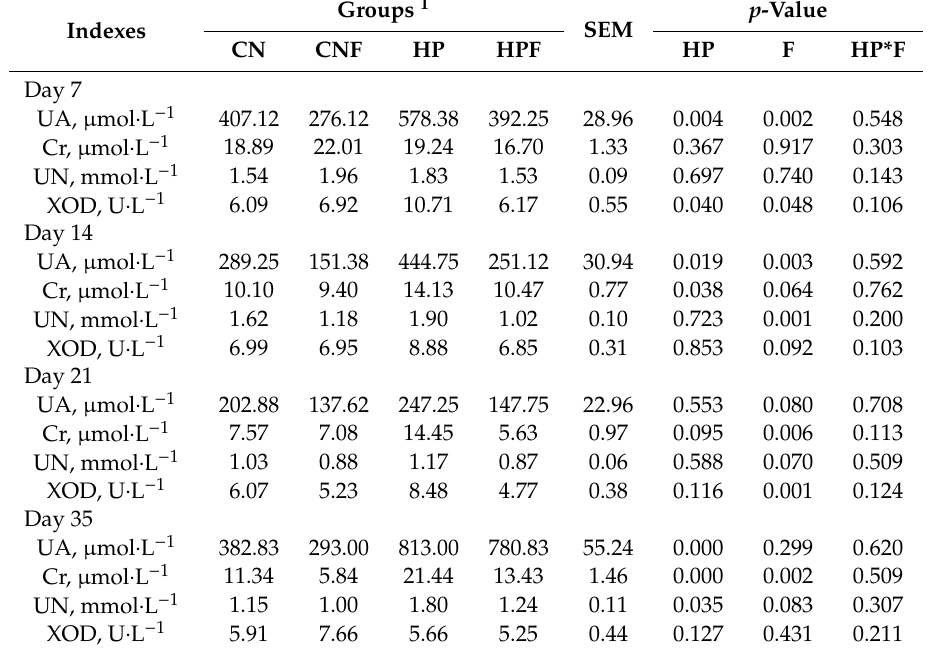
Table 4. E ff ects of high-protein diet and fermented feed on kidney function in goslings in Experiment